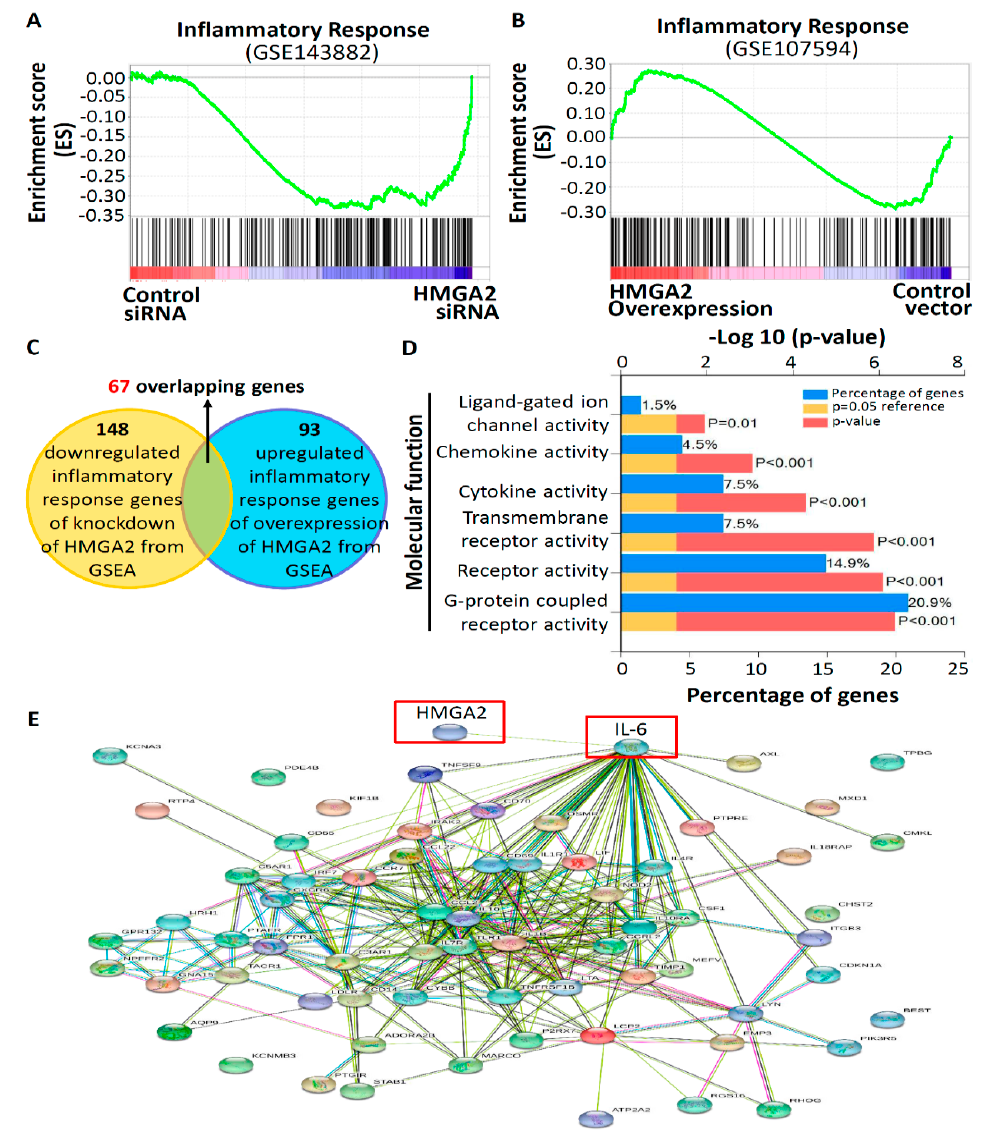
Figure 4. Expressions of inflammatory response genes related to the HMGA2 expression status. Gene set enrichment analysis (GSEA) showed enrichment of a downregulated inflammatory response gene